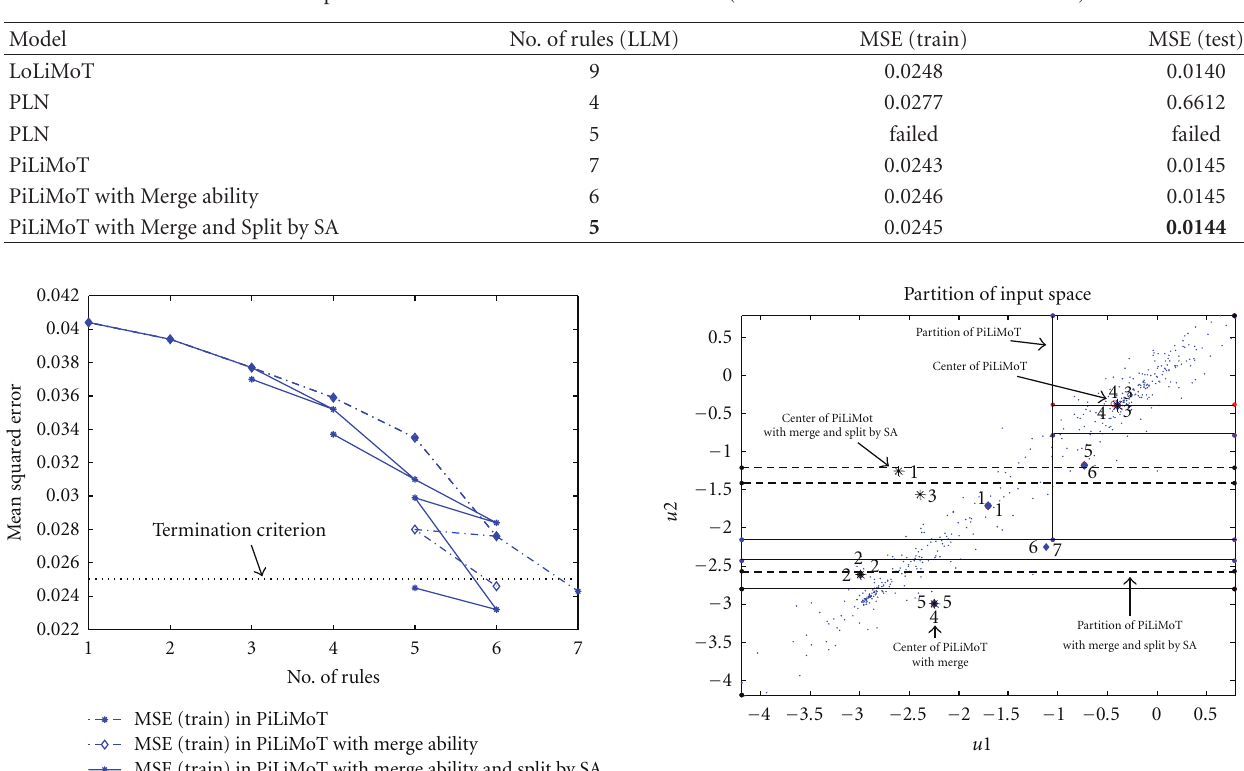
Table 1: The comparison of PiLiMoT with LoLiMoT and PLN (in same number of rules or same MSE).